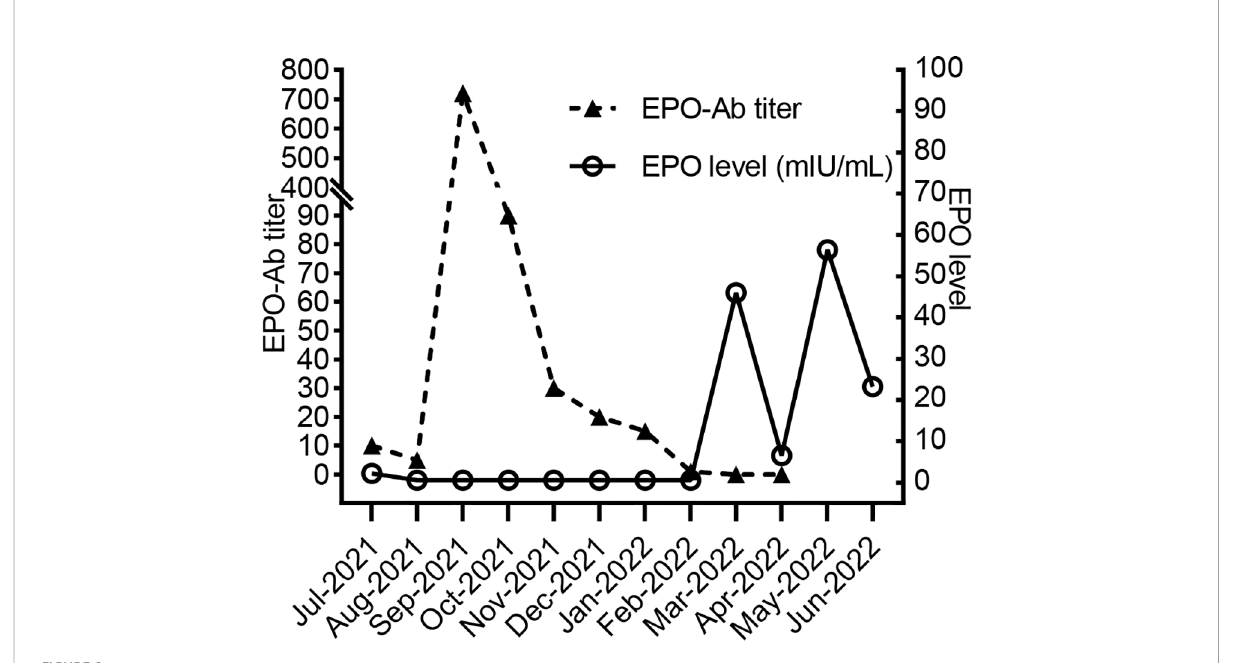
FIGURE 2 EPO antibody titer and EPO levels of the